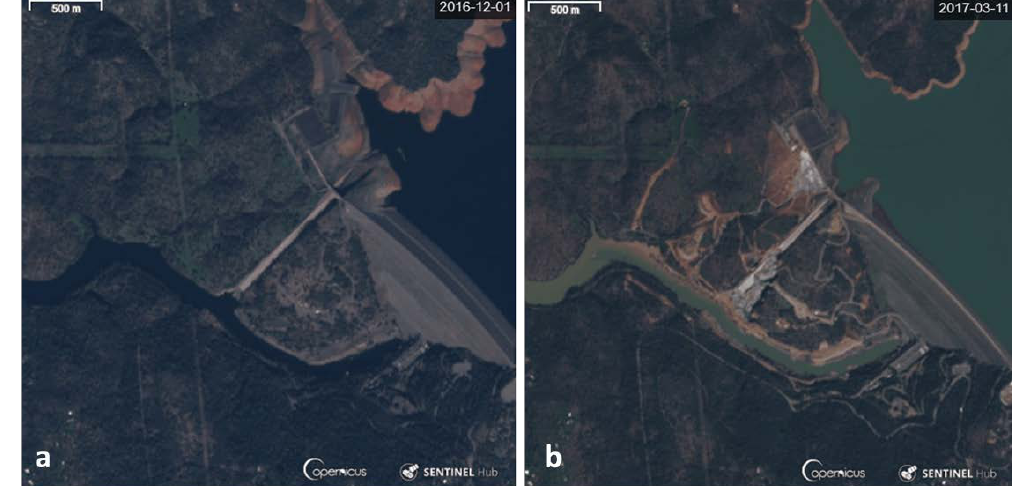
Figure 3. Oroville dam, California, USA, ( a ) before and ( b ) after the spillway incident occurred in February 2017, in two satellite multispectral images collected on 1 December 2016 and 11 March 2017, respectively (contains Copernicus Sentinel-2 data 2016–2017). The full time-lapse is provided in the Supplementary Materials.